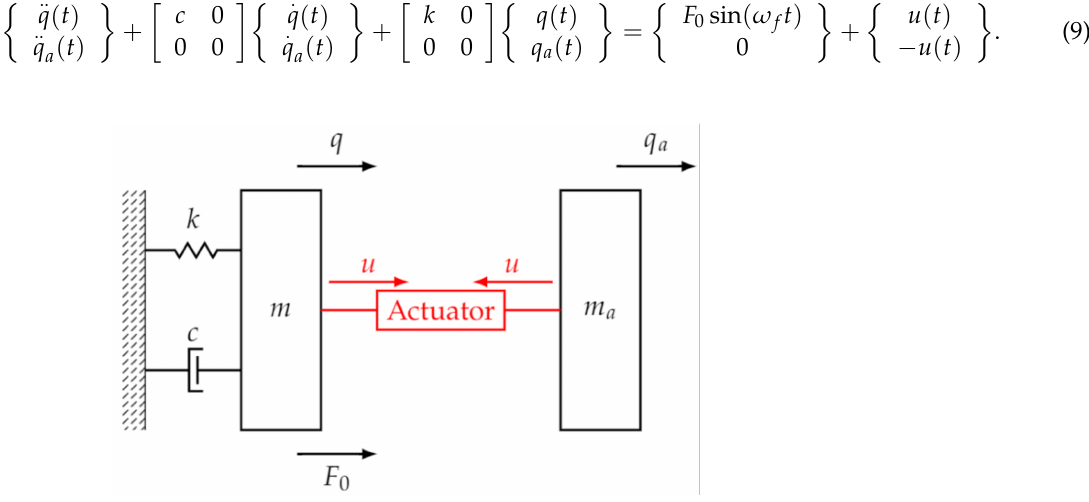
Figure 2. Sketch of the original system with the ATMD in the numerical example. The control gains in Equation (8) are computed in this example exploiting different approaches, proposed for passive TMDs, to fulfill different control specifications. The selected tuning methods are briefly reported here in Table 1. Each method has been denoted by a number that spans from 1 to 5. The optimization goal fulfilled through each tuning method is here reported (for a more deep analysis see [16,22]):